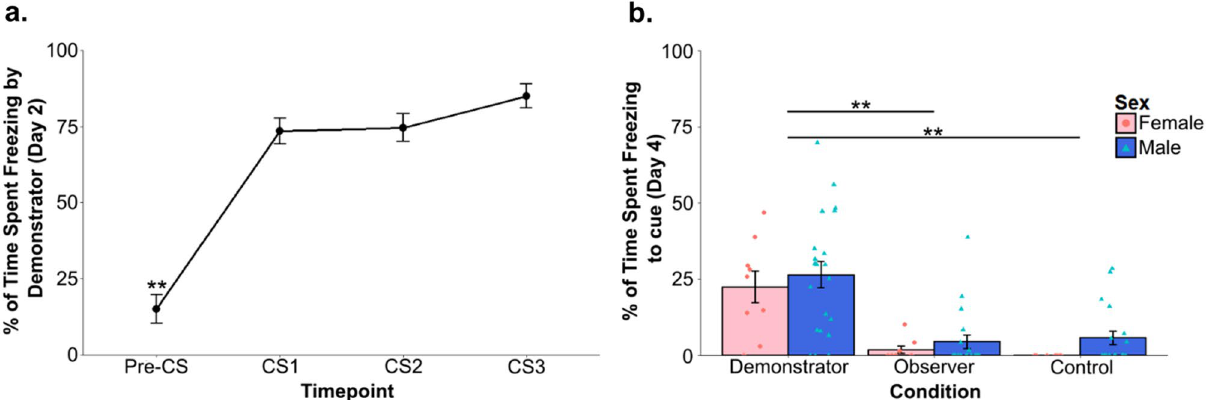
Figure 3. Fear conditioning and fear conditioning by-proxy behavioral results. The above figures show the average percent of total time that rats froze during or prior (Pre-CS) to the CS presentation for ( a ) Demonstrators on day 2, during FCbP interactions and ( b ) all rats to the single CS presentation on the terminal day of the experiment. While demonstrators froze significantly more than both observers and controls, unusually, observers did not freeze significantly more than controls. Values are the mean ± SEM. **p <